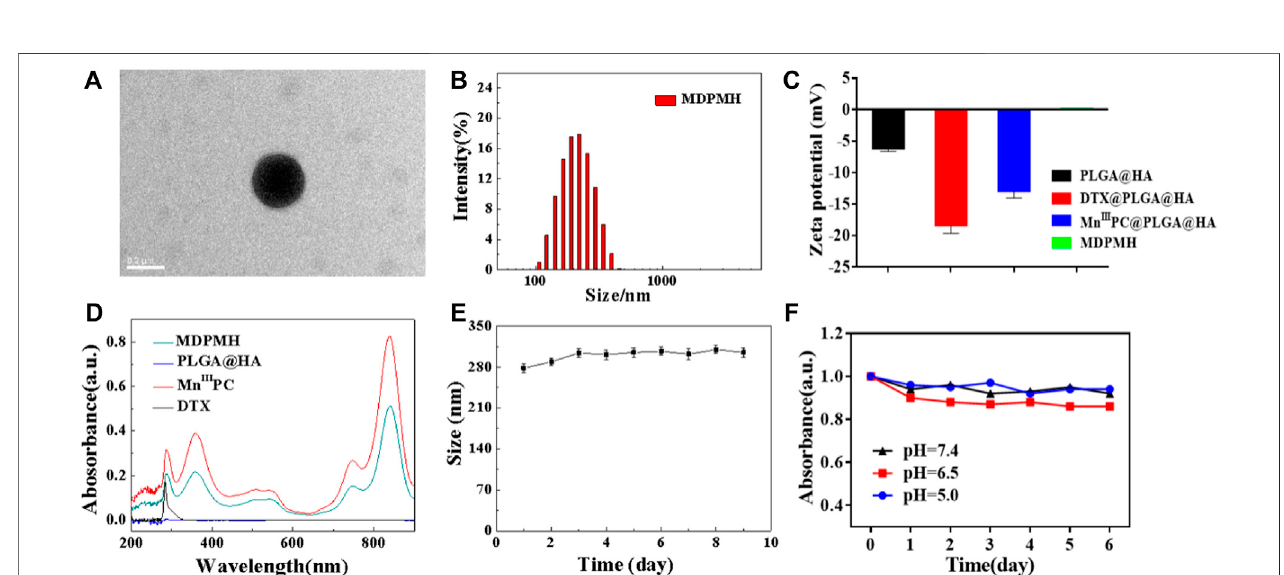
FIGURE3|(A) TEMimageMDPMH,scalebar=0.2 μ m. (B) ThesizedistributionofMDPMH. (C) ZetapotentialofPLGA@HA,DTX@PLGA@HA,Mn III PC@PLGA@ HA, andMDPMH. (D) TheUV-visspectraofDTX,Mn III PC,PLGA@HA, andMDPMHfrom 200to1,000 nm. (E) ThesizechangeoftheMDPMH dispersedinthemixture solution of DMSO and H 2 O. (F) The absorption spectrum of MDPMH nanoparticle under different pH conditions (5.0, 6.5, 7.4) in 6 days.